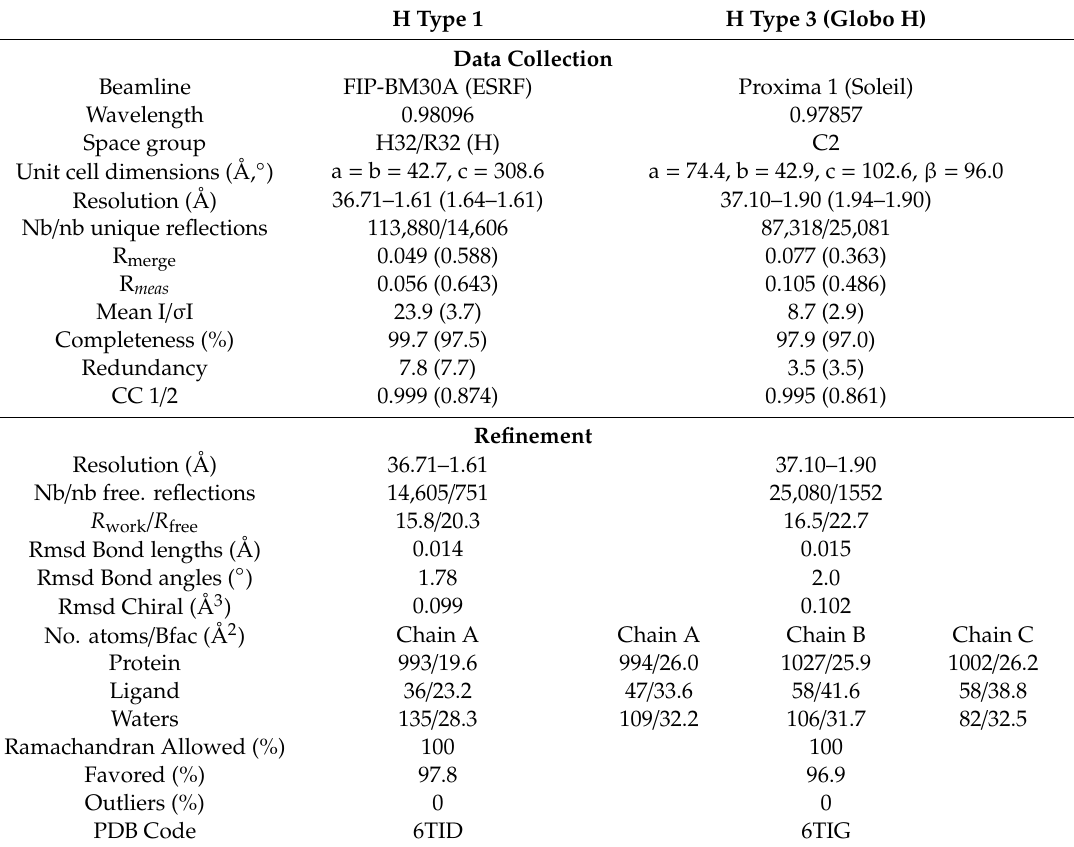
Table 2. Data collection and refinement